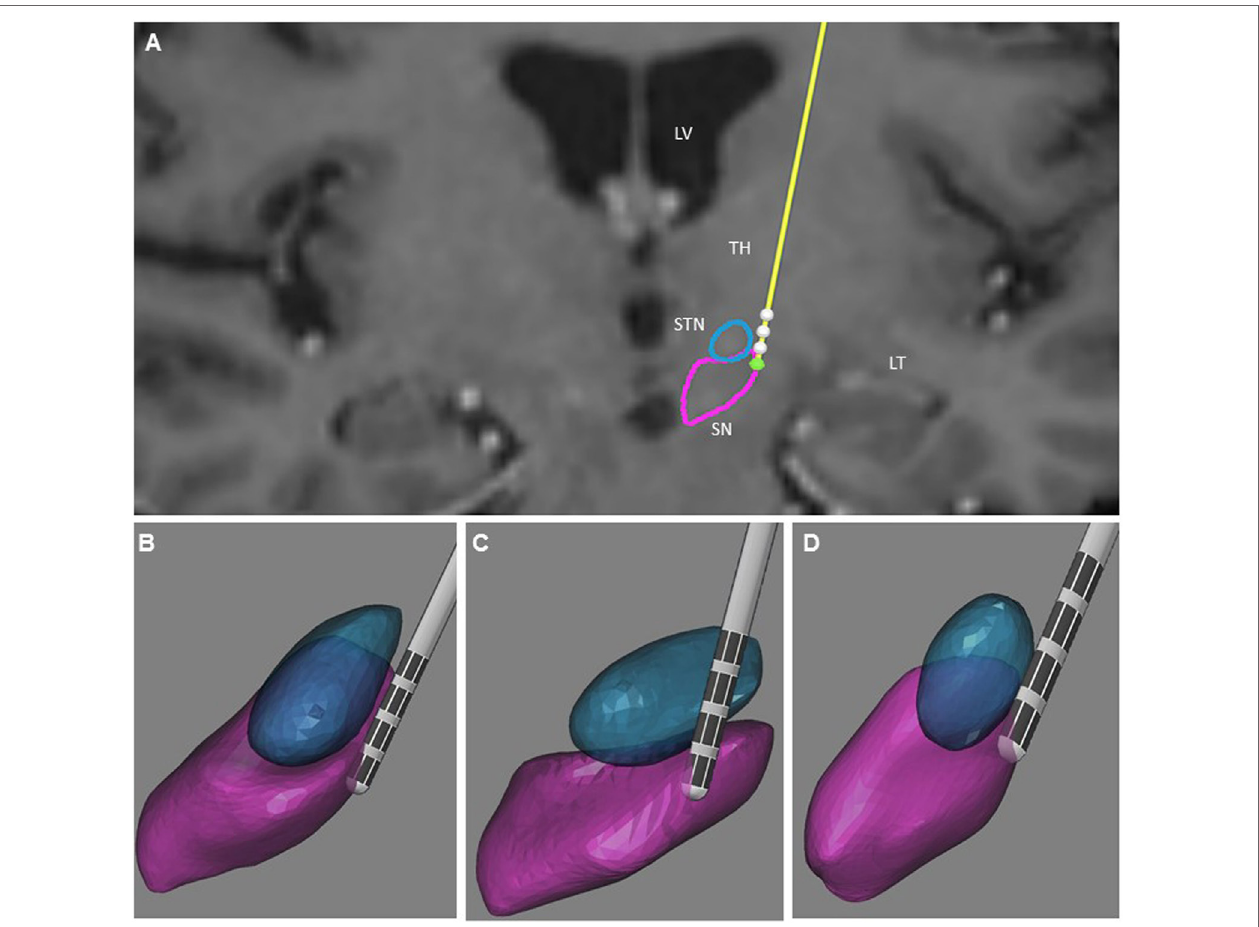
FIgURe 2 | Illustration of the three-dimensional anatomical location of the electrodes (patient 2). (a) Frontal view of the electrodes (in yellow) with the different contacts (white) and three-dimensional view of the STN (in blue), and SNr (in purple). This representation is superimposed on the coronal T2 preoperative MRI of patient 2 to illustrate the location of the STN and SNr. Each electrode had four contacts with the length of 1.5 mm separated by 0.5 mm intervals and numbered from 0 to 3 in the left hemisphere. Contact 0 is the deepest contact (green). (B) Frontal view of the left STN and SNr. (C) Anterolateral view of the left STN and SNr. (D) Superior view of the left STN and SNr. In (B–D) , the STN and SNr were represented in transparency to show the location of the contacts and visualize the “laughter” contact 0 localized within the SNr. LV, lateral ventricle; TH, thalamus; TL, temporal